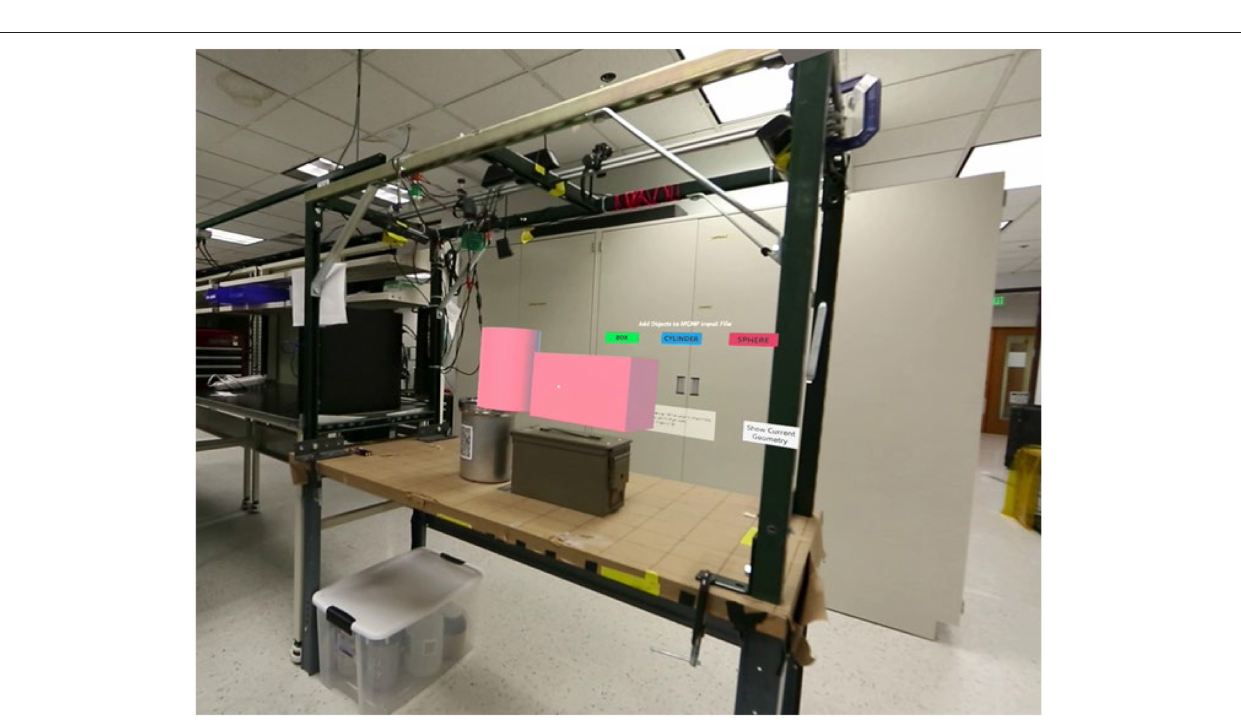
Methods, Codes, and Applications Group–Los Alamos